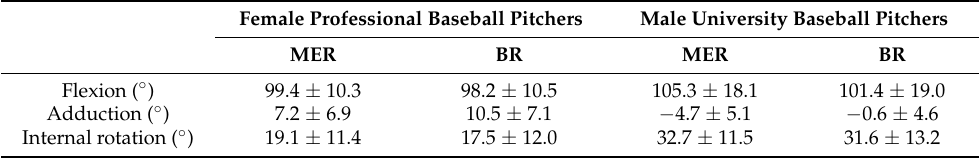
Table 5. Hip joint